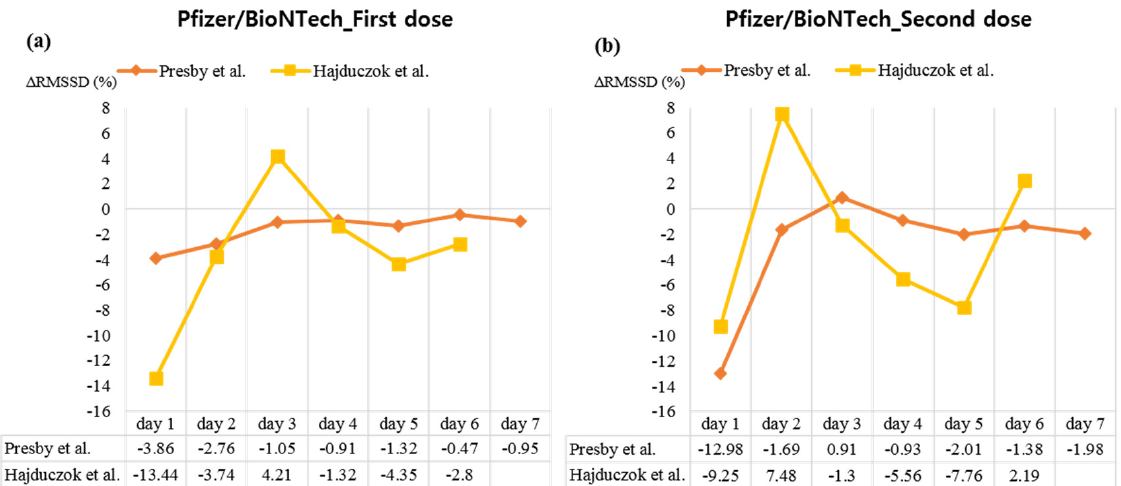
Figure 3. Changes of heart rate variability from baseline after Pfizer/BioNTech vaccinations. Abbre- viations. RMSSD, the square root of the mean squared differences of successive NN intervals. Note .